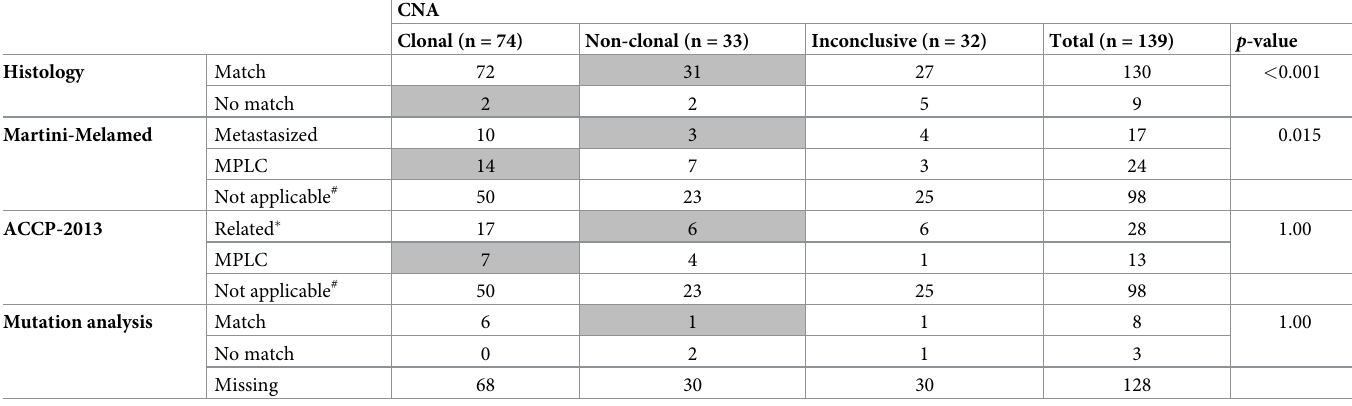
Table 3. CNA compared to other methods for clonality analysis. Highlighted in grey are discordant results. P-values from McNemar